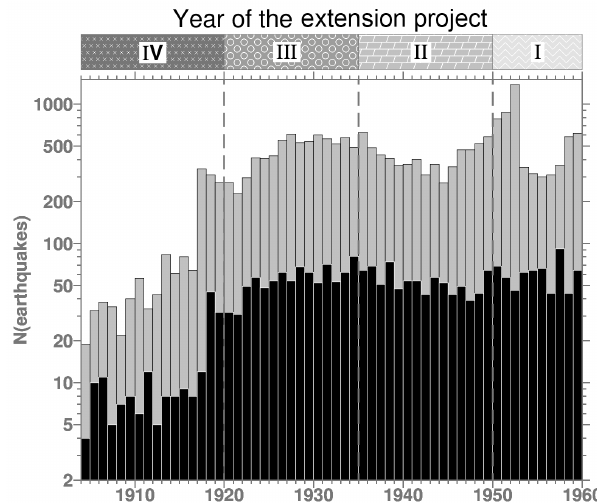
Figure 1. Annual number of pre-1960 earthquakes in V1 of the ISC-GEM Catalogue (black, total = 2439 events) and the events that are available in the ISS between 1918 and 1959 and the aug- mented Centennial Catalogue/BAAS between 1904 and 1917 (grey, total of 20865 events) that were not processed for V1 (in the text referred to as extension events). The hachure patterns on top outline the period extended in each year of the Extension Project: 1950– 1959, 1935–1949, 1920–1934 and 1904–1919 in Year I, II, III and IV, respectively. The period 2010–2014, not shown here, has also been progressively added during the Extension